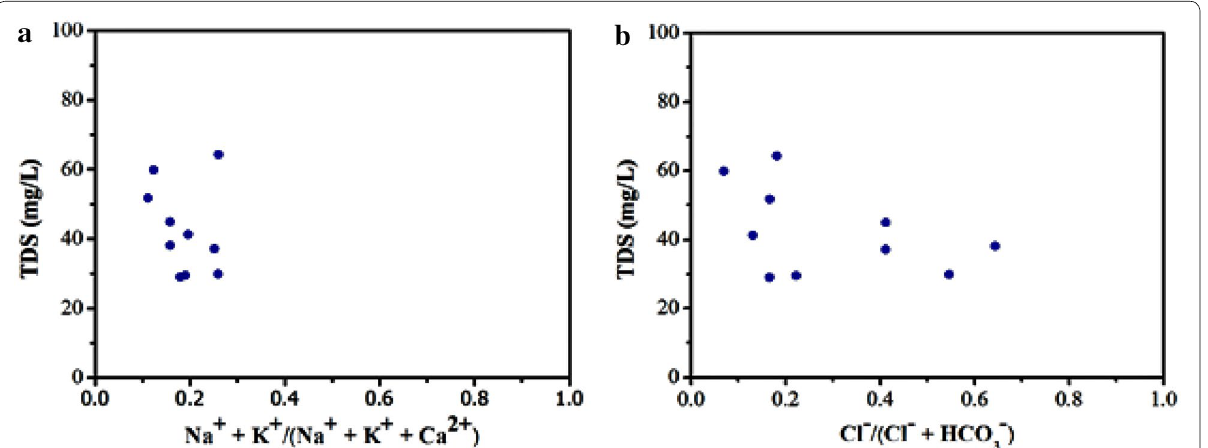
Fig. 4 Gibbs diagram showing the ratio of a Na +